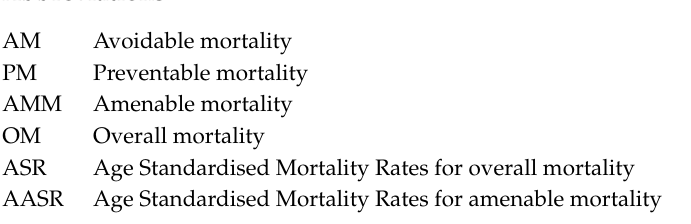
s1. Table S1: Indices of economic impact of the crisis in Spain by province, Table S2: Frequencies of death by sex and group of causes (overall and amenable mortality). Spain 2002–2007 and 2008–2013, Table S3: Standardised mortality rates, relative decreases, and 95% confidence intervals, by province. Periods 2002–07 and 2008–13. Men, Table S4: Standardised mortality rates, relative decreases, and 95% confidence intervals, by province. Periods 2002–07 and 2008–13. Women, Figure S1: Overall and amenable mortality annual standardised rates for the study period in Spain